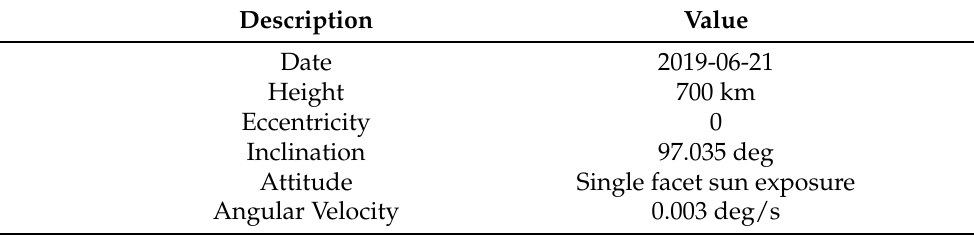
Table 4. Initial orbital properties for TRIAD simulation.